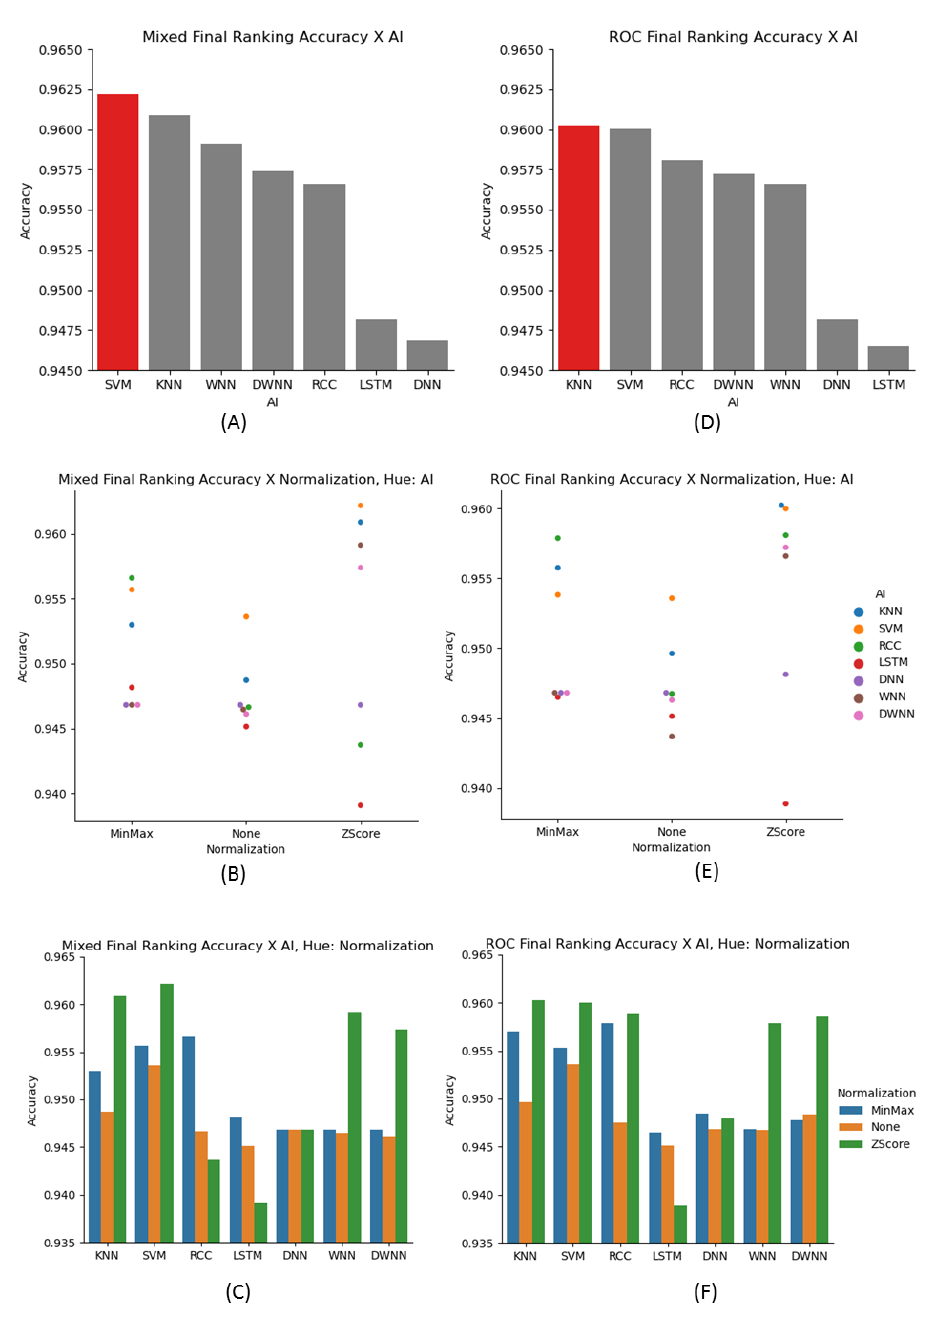
Figure 9. Classification performance. ( A – C ): Classification ranking in the Mixed dataset. ( D – F ): Classification ranking in the ROC dataset. ( A , D ): The best performance ranking mixing the nor- malization. ( B , E ): Accuracy in regard to normalization. ( C , F ): An overall ranking among models and